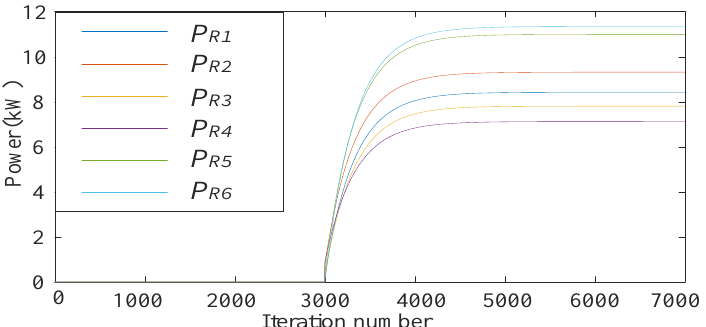
Figure 10. The power of each customer with ε = 1/6000.